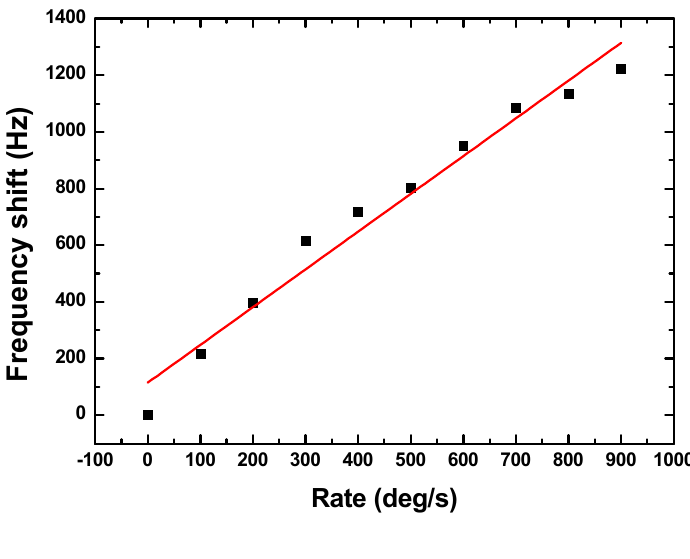
Figure 8. Sensitivity evaluation of the fabricated SAW